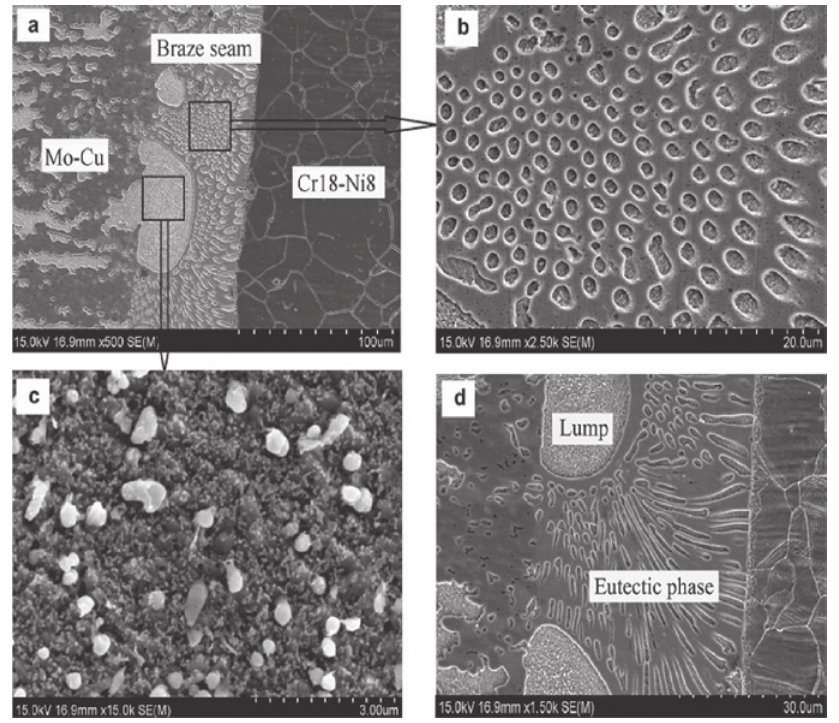
Fig. 4: Microstructure characteristics of (a) joint, (b) eutectic phase, (c) lump structure, and (d) braze seam